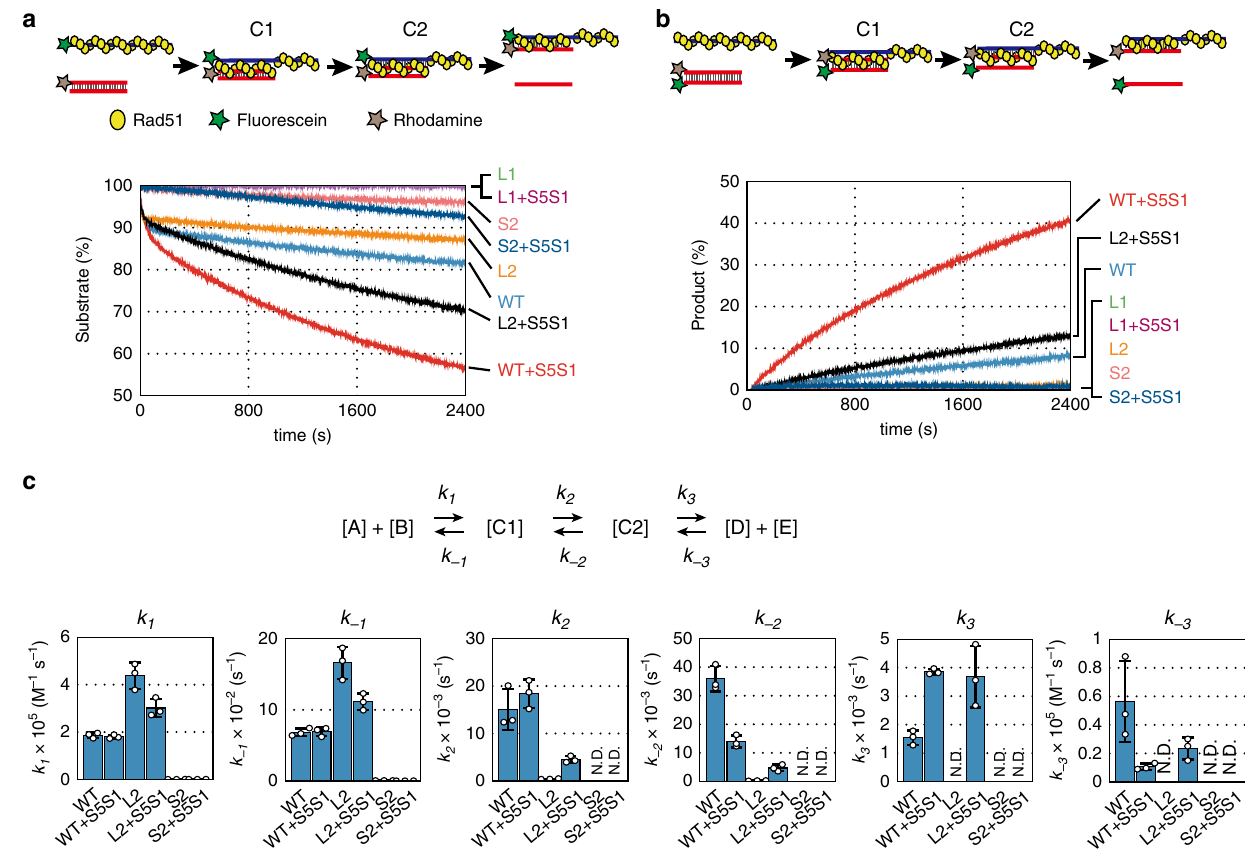
Fig. 2 DNA strand exchange in real time. a FRET-based real-time assays for the Rad51-mediated DNA strand pairing reaction. (upper) Schematic diagram of the pairing reaction. Yellow circles represent Rad51 monomers. Green and brown stars represent fl uorescein and rhodamine, respectively. (lower) Time course of the DNA strand pairing reaction. Reactions containing fl uorescein-labeled presynaptic fi laments (83 nt) consisting of wild-type Rad51, Rad51-L1 (L1), Rad51-L2 (L2), or Rad51-S2 (S2) (1.5 µ M each) with/without Swi5-Sfr1 (0.15 µ M) were started (time = 0) by addition of donor dsDNA (40 bp), which was labeled with rhodamine at the end of the complementary strand of the presynaptic fi lament. Fluorescence emission was monitored at 525 nm upon excitation at 493 nm. Wild-type Rad51; light blue, wild-type Rad51 with Swi5-Sfr1; red, Rad51-L1; green, Rad51-L1 with Swi5-Sfr1; purple, Rad51-L2; yellow, Rad51-L2 with Swi5-Sfr1; black, Rad51-S2; orange, Rad51-S2 with Swi5-Sfr1; dark blue. b FRET-based real-time assays of the Rad51-mediated DNA strand displacement reaction. (upper) Schematic diagram of the displacement reaction. (lower) Time course of the displacement reaction. Reaction conditions were the same as in ( a ), except that the two ends of the donor dsDNA were labeled with fl uorescein and rhodamine. c The upper panel shows the schematics of the three-step reaction. In the reaction formula, [A], [B], [C1], and [C2] correspond to the concentrations of presynaptic fi lament, donor dsDNA, C1 intermediate, and C2 intermediate, respectively. [D] and [E] correspond to the two products of the strand exchange reaction, heteroduplex DNA, and released ssDNA, respectively. The lower panel shows rate constants for DNA strand pairing derived from the DynaFit-based fi tting procedure applied to the data obtained in ( a ). Data are expressed as the mean ± s.d. ( n = 3 independent experiments). See also Supplementary Table 2. Source data are provided as a Source data fi and C2, and that Swi5-Sfr1 stimulates the C1 – C2 transition and the fi nal DNA displacement step. The reaction curve showing